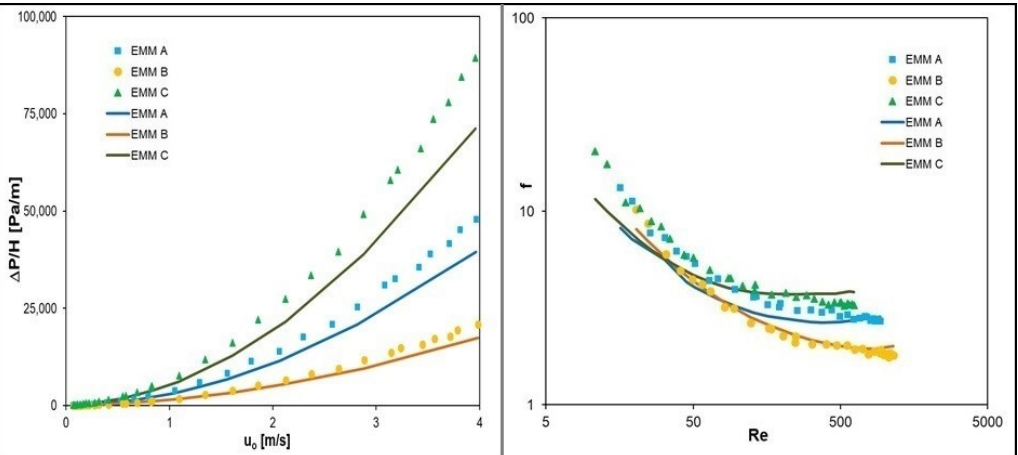
Figure 5. Flow resistance characteristics derived from experiments (points) and modeling (lines): ( left )—unit pressure drop vs. superficial gas velocity; ( right )—Fanning friction factor vs. Reynolds number.